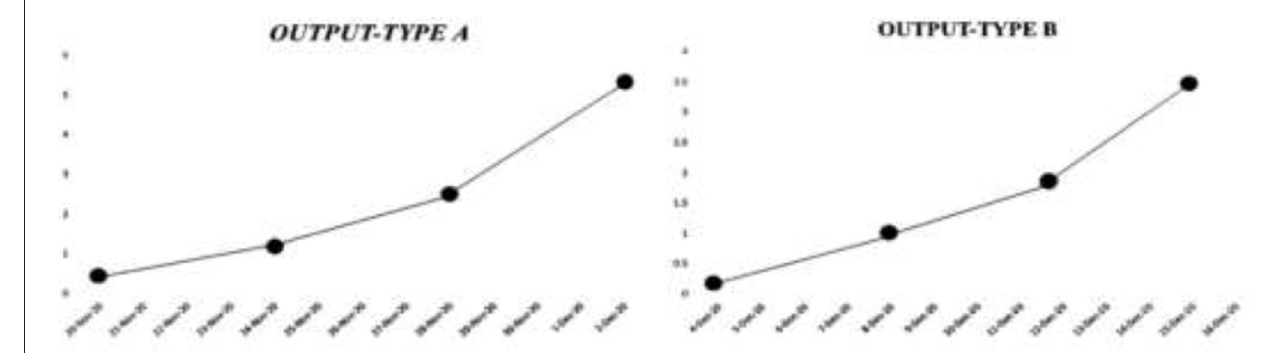
FIGURE 10 | Hybrid output energy voltage according to type of solution.